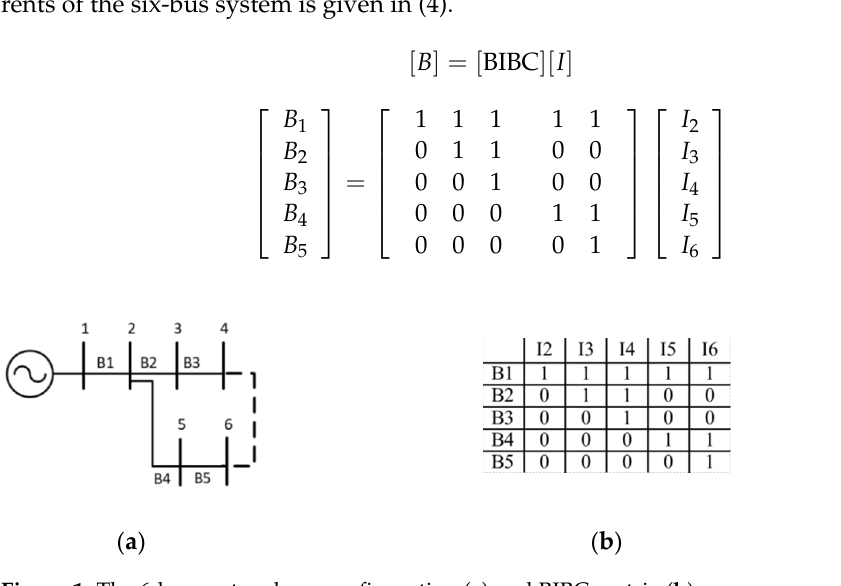
Figure 1. The 6-bus system base configuration ( a ) and BIBC matrix ( b ).